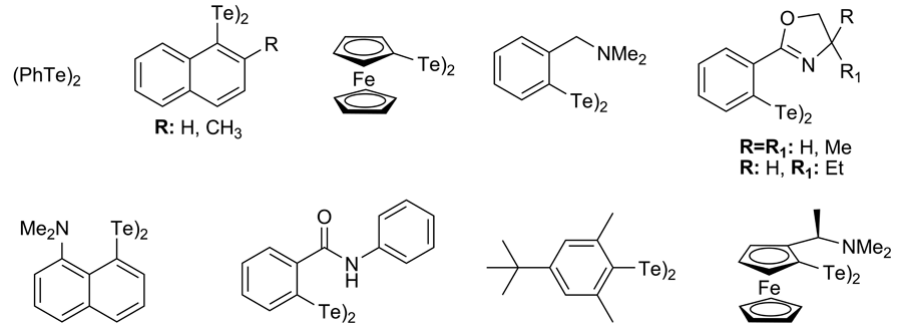
Fig. 6 – Diorganil ditellurides with mimetic GPx activity.